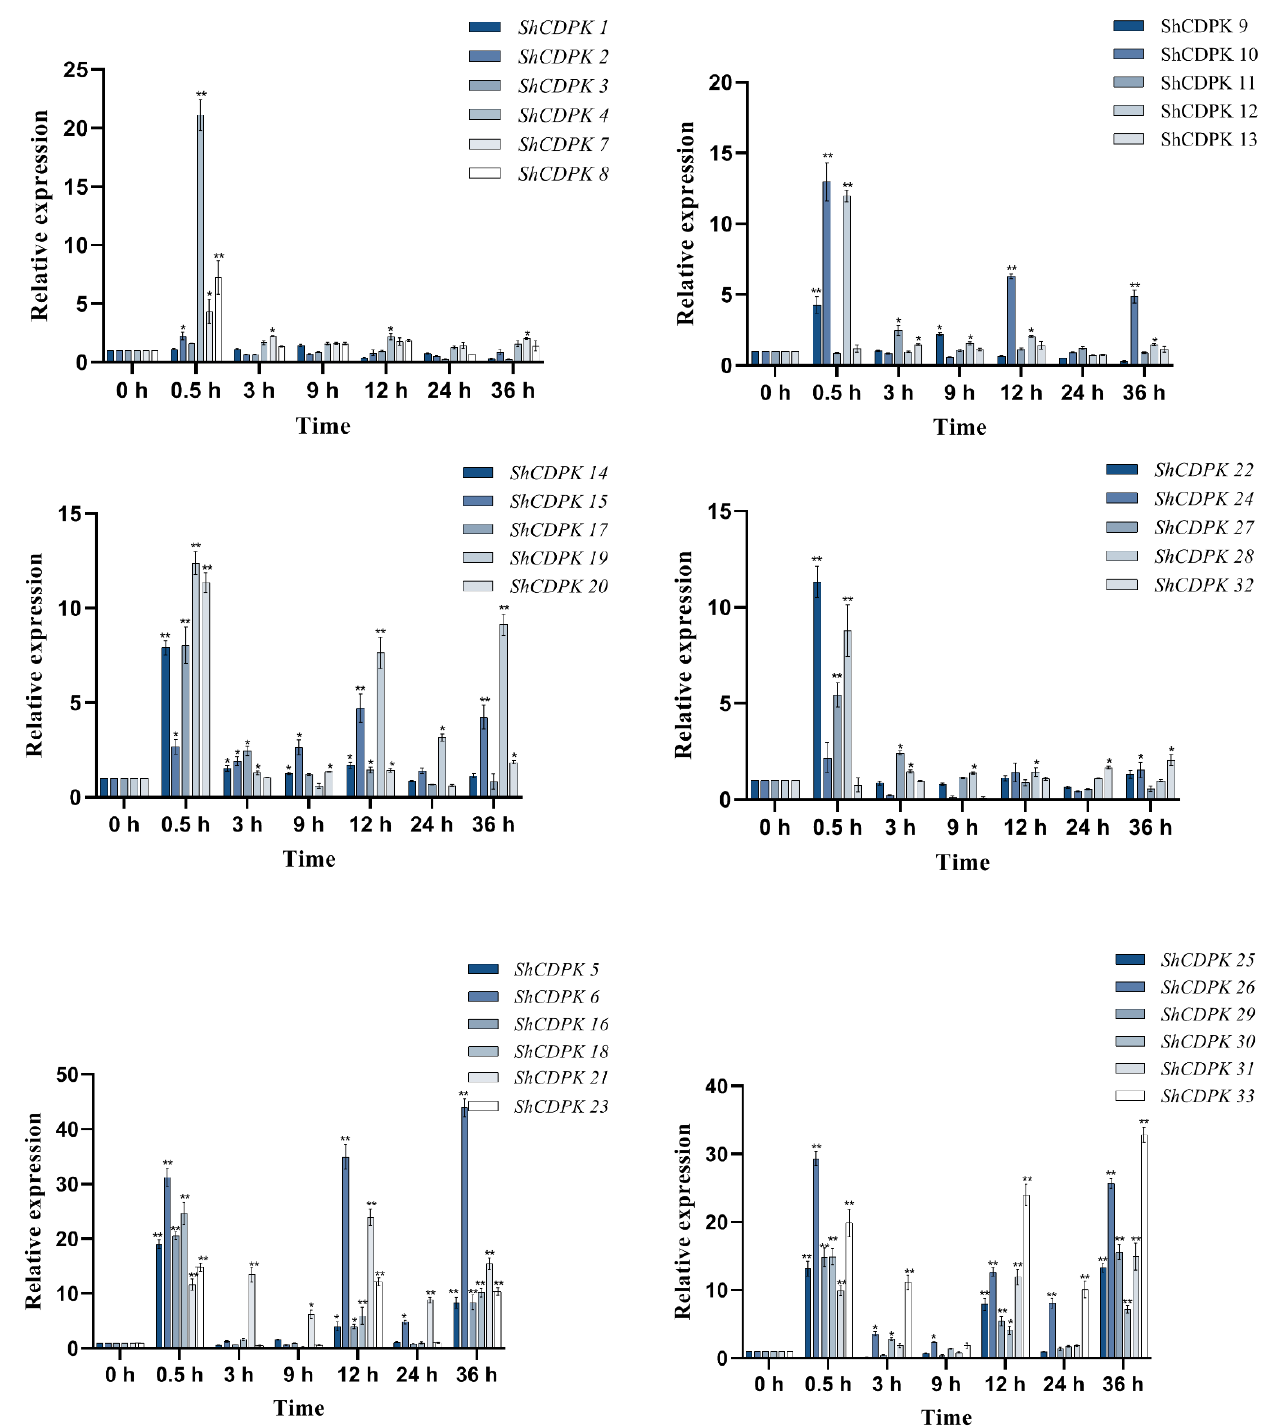
both genes was 43.9 times and 32.8 times higher than that of the control. The peak values